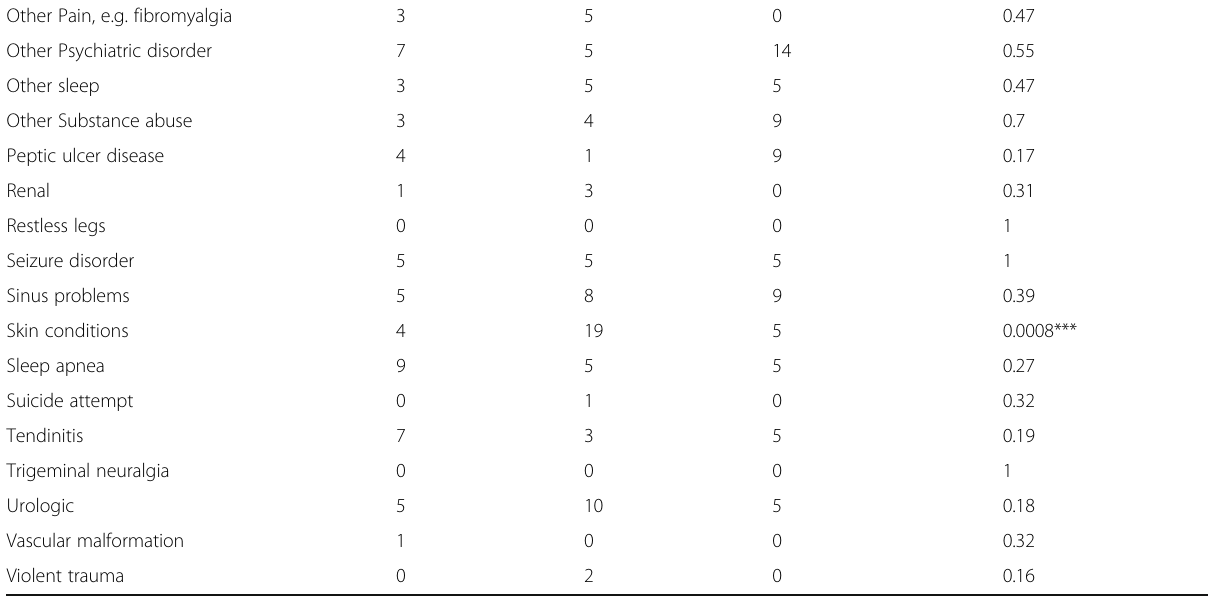
Table 2 Demographic characteristics and prevalence of comorbid conditions in patients with definite and unconfirmed CH and controls (Continued)